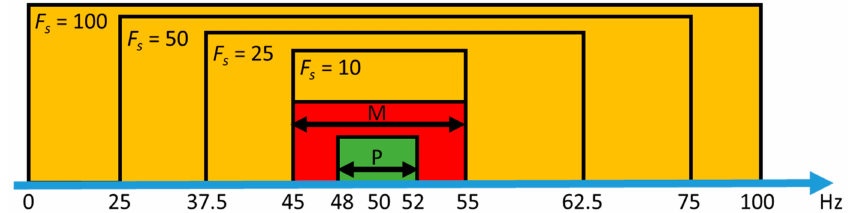
Figure 3. In band ranges for di ff erent reporting rates F s and maximum modulation bandwidths required for the P class (green) and M class